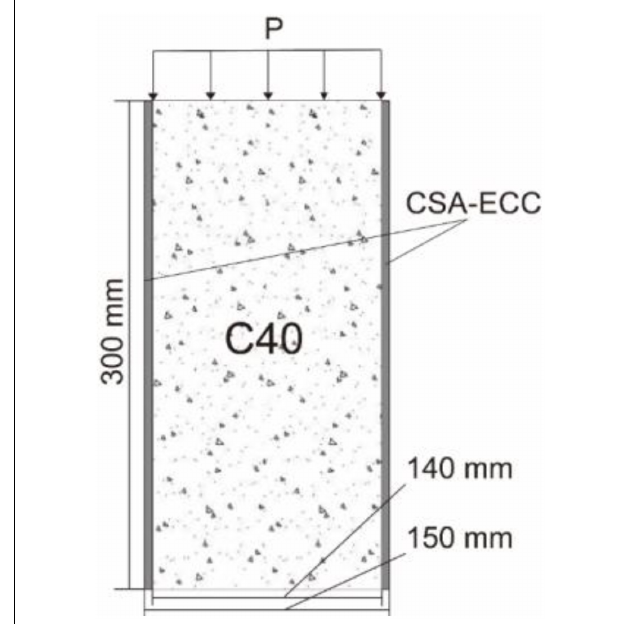
FIGURE 5 | Schematic of the repaired concrete column under compressive strength